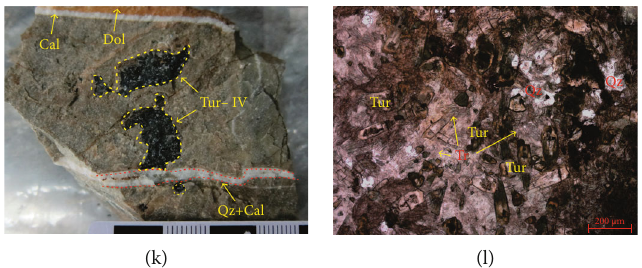
Figure 4: Photographs of hand specimens and photomicrographs showing mineral assemblages of the Xinmin deposit. (a) Bismuthinite, pyrite, sphalerite, and chalcopyrite fi lling in the metapelite. (b) Pyrite, sphalerite, chalcopyrite, and galena disseminated in the breccia. (c) Tourmaline, pyrite, sphalerite, chalcopyrite, and galena occurring as vein in skarn. (d) The chalcopyrite was replaced by bismuthinite. (e) The optical heterogeneity of marcasite, late stage. (f) Chalcopyrite as emulsion droplet within sphalerite, making an exsolution texture. (g) Octahedrite and anhedral pyrite (PyII). (h) Euhedral pyrite (PyI) in the skarn. (i) Simultaneous pyrrhotite, sphalerite, and galena. (j) Euhedral fi ne grain-size tourmaline and quartz. (k) Quartz, calcite, and dolomite vein in the skarn. (l) Short columnar tourmaline, anhedral quartz, and fabric tremolite in the skarn. Mineral abbreviations (after [19]): Bm: bismuthinite; Ccp: chalcopyrite; Cal: